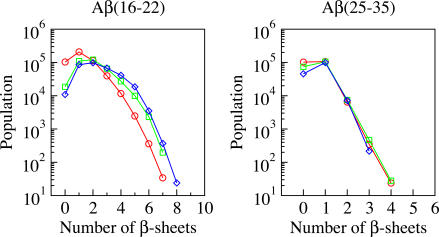
Populations of Oligomers as a Function of the Total Number of β Sheets Contained within the OligomersThe hydrophobic interactions that drive the coalescence and hence the formation of Aβ16–22 oligomers (left), results in aggregates with complex structures containing many small β sheets. On the other hand, the hydrogen bond interactions that drive the oligomerization of the Aβ25–35 fragments (right) result in simpler structures with a small number of β sheets.